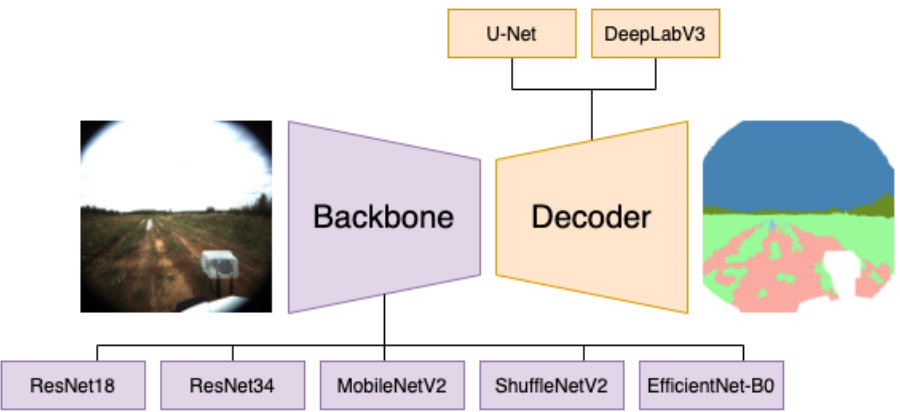
Figure 2. Proposed backbones and decoders